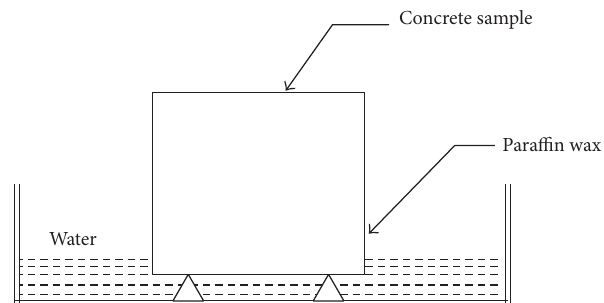
Figure 3: Details of water sorptivity